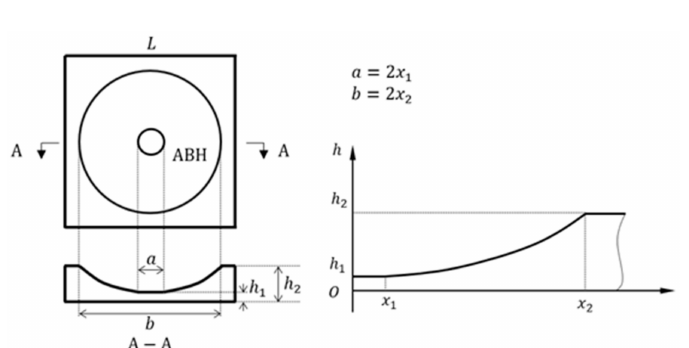
Figure 2. A typical two-dimensional ABH